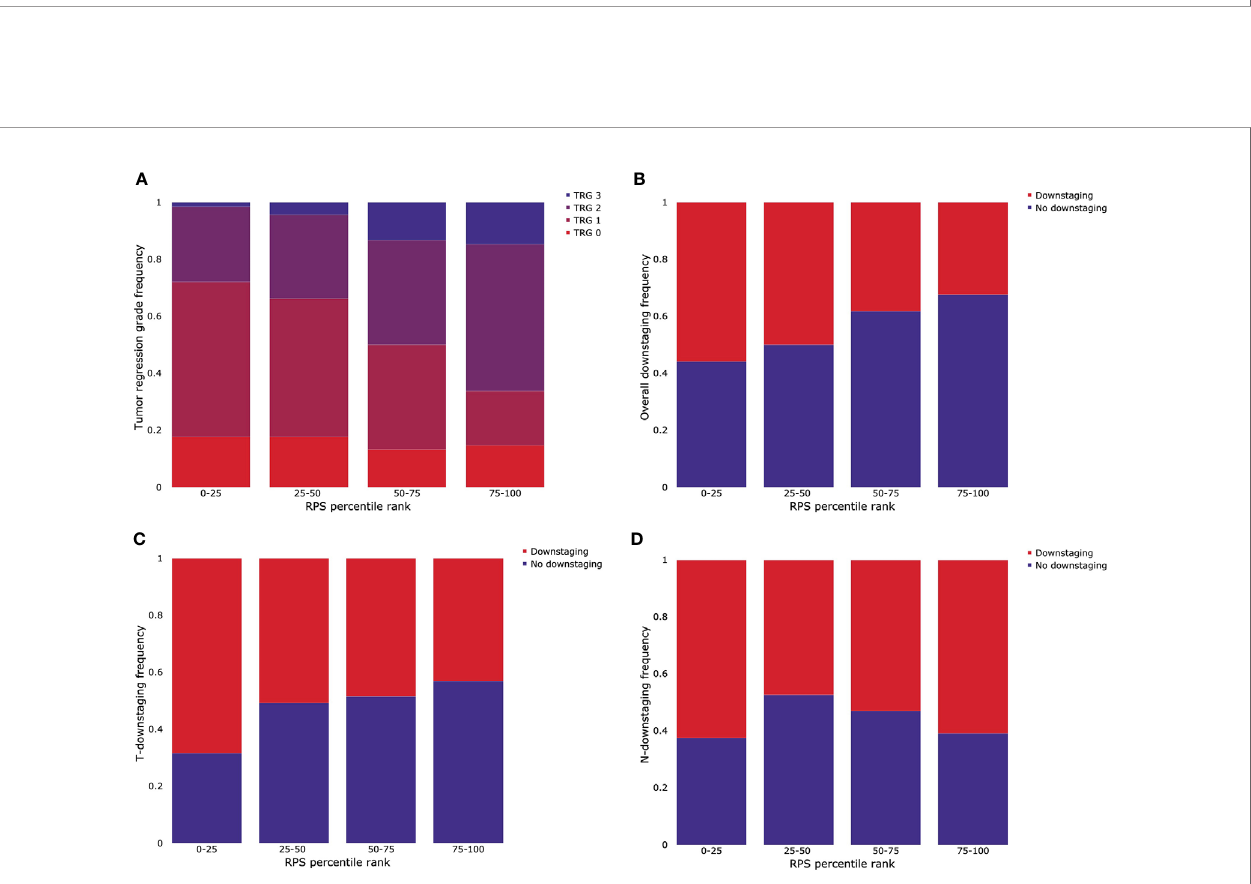
FIGURE 5 | Strati fi cation of outcomes for CRT by quartile grouping using the RPS system. (A) Tumor regression grade (TRG), (B) overall downstaging, (C) T-downstaging, and (D)